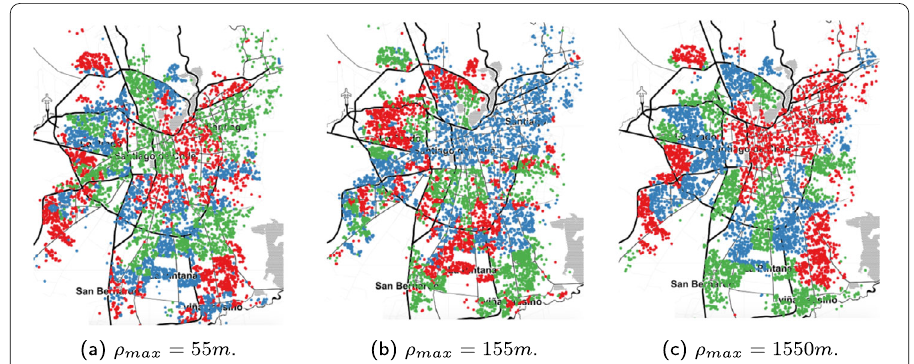
Figure 2 ρ max calibration. For high values of ρ , the local structures of the clusters are lost. The best results are obtained for ρ in walkable ranges, between 55 and 155 meters around each territorial